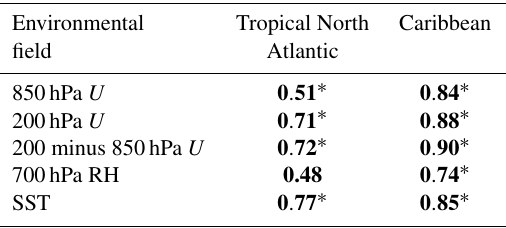
Table 4. Correlation matrix between JJA and ASO values of SST over the tropical North Atlantic and the Caribbean, respec- tively. Correlations that are statistically significant at the 90% level are highlighted in bold, and those with asterisks are statistically sig- nificant at the 95%